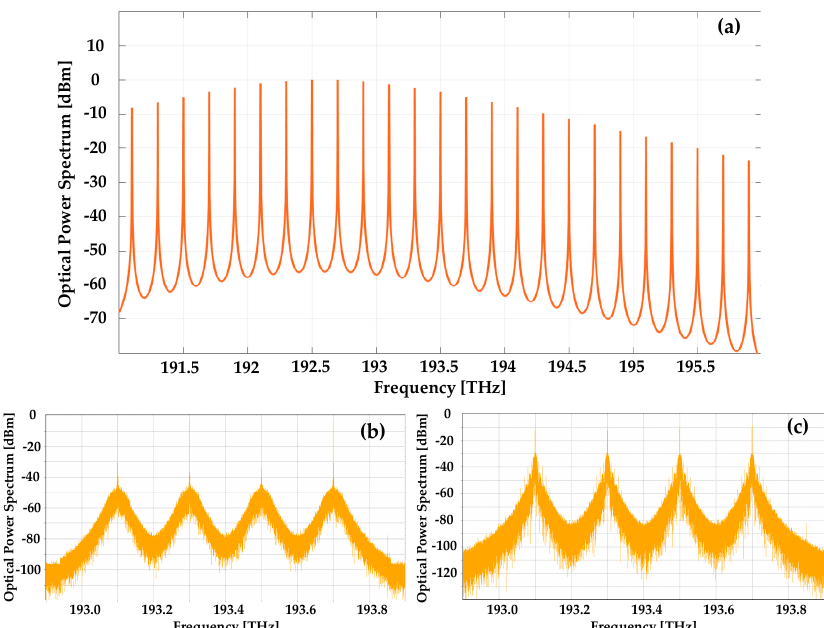
Figure 10. Optical spectra: ( a ) after user-defined OBPF with implemented microsphere-based OFC comb source, ( b ) after OBPF-four optical carriers from microsphere-based OFC comb source, ( c ) modulated optical carriers after B2B transmission for 4-channel 200 GHz spaced IM / DD WDM-PON system operating at 10 Gbit / s per channel.